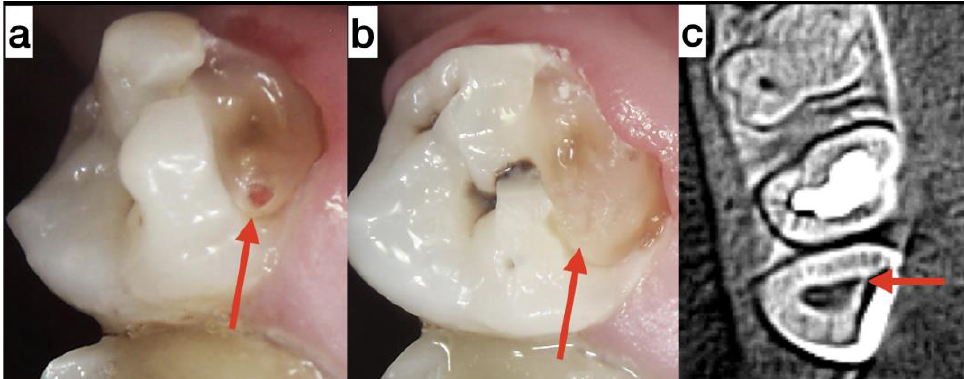
Figure 3. ( a ) Cavity without carious dentin — the red arrow indicates communication with the dental pulp. ( b ) Exposed cavity — dental pulp communication was covered by reparative dentin. ( c ) Cone- beam computed tomography images of tooth 18 five months after treatment (axial section). Dental pulp communication was covered by reparative dentin (red arrow).